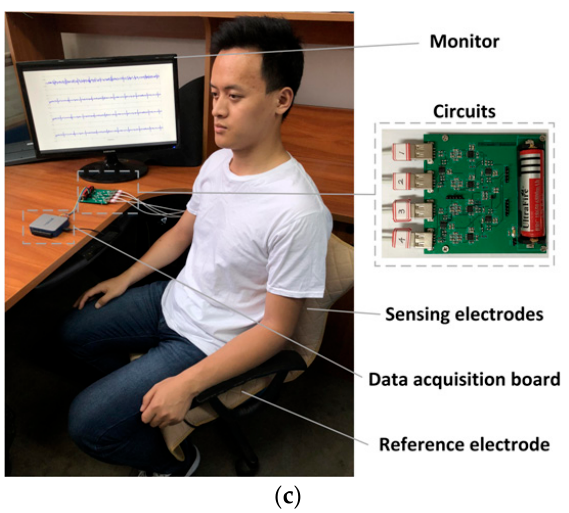
Figure 3. The ECG signal acquisition system: ( a ) Picture of the electrode positions; ( b ) Signal acquisition